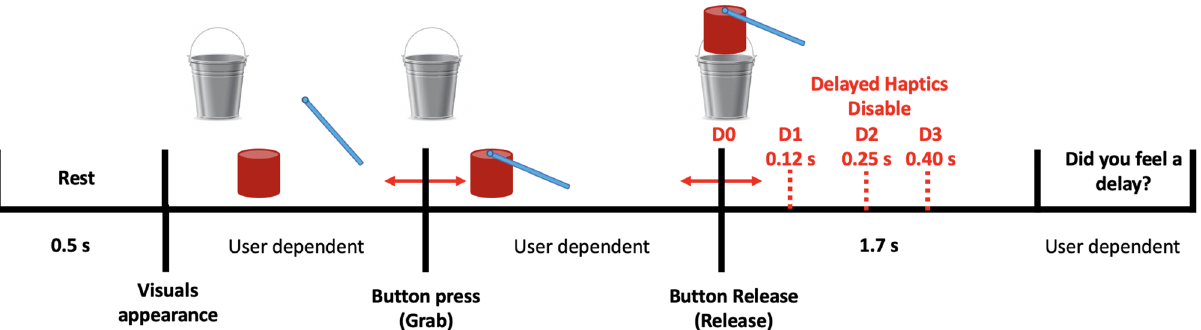
Figure 2. Schematic representation of the experimental task. Once the object is released, the haptic feedback represented by the object’s weight continues to be enabled under the presence of haptic delay. This delay could be either 120 ms, 250 ms, or 400 ms. Under the absence of haptic delay, the haptic feedback is disabled once the object is released, and thus, the visual and haptic modalities are in synchrony. After every trial, participants indicated whether they felt a delay or